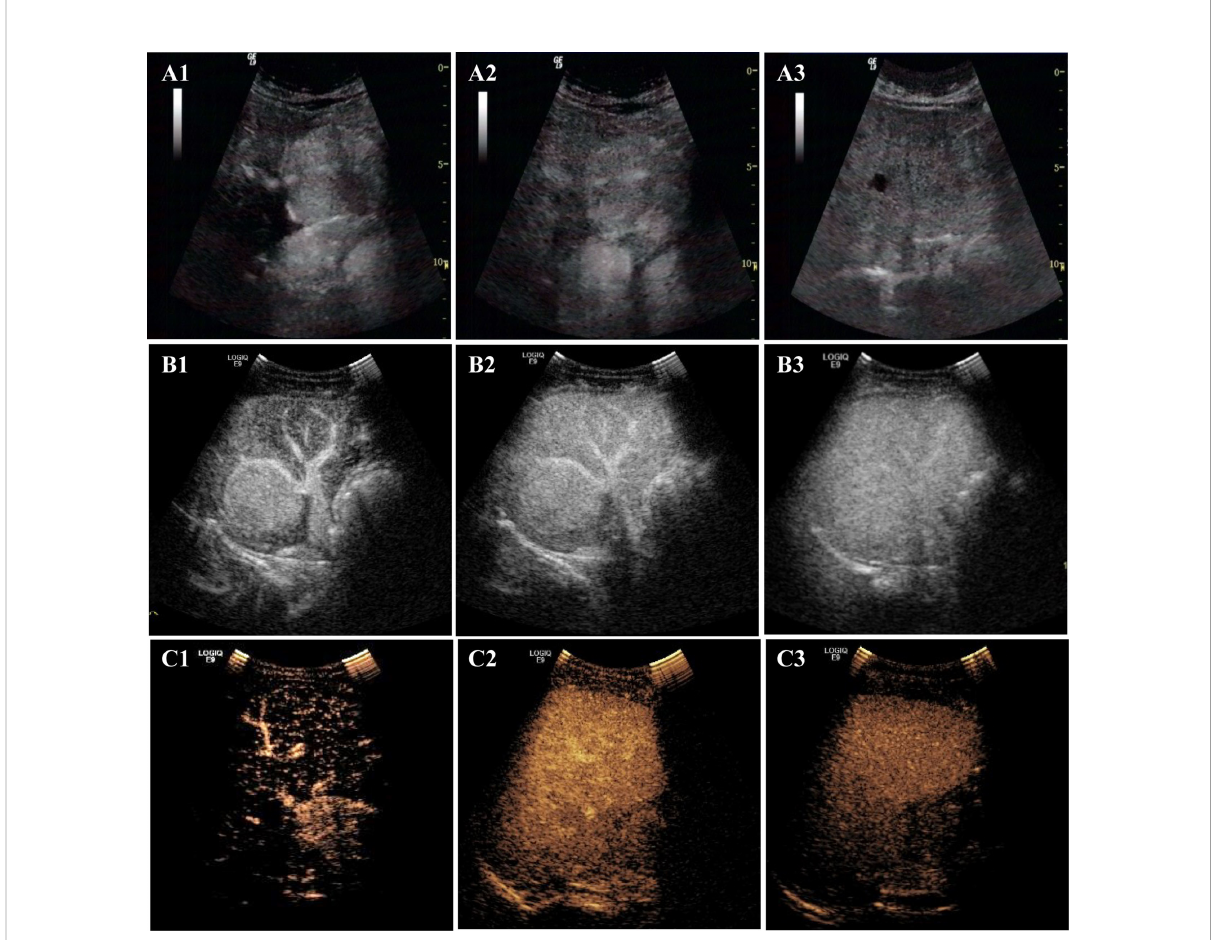
FIGURE 3 The enhancement patterns of CEUS. The enhancement pattern of CEUS was “ fast in and slow out ” (FISO). A1, A2, and A3 are CEUS images of lesions in the patient 4: (A1) rapid enhancement in the arterial phase; (A2) slightly higher enhancement in the portal phase; (A3) the lesion began to wash out at 300s in delayed phase. B1, B2, and B3 are CEUS images of lesions in the patient 1. (B1) rapid enhancement in arterial phase with large blood vessels; (B2) in portal phase, the lesion was still hyper-enhanced; (B3) the lesion did not wash out at 360s in delayed phase. C1, C2, and C3 are CEUS images of lesions in the patient 2. (C1) rapid enhancement in arterial phase; (C2) the lesion began to wash out at 68 s in portal phase fade; (C3) The lesion was observed with low-enhancement in delayed phase.